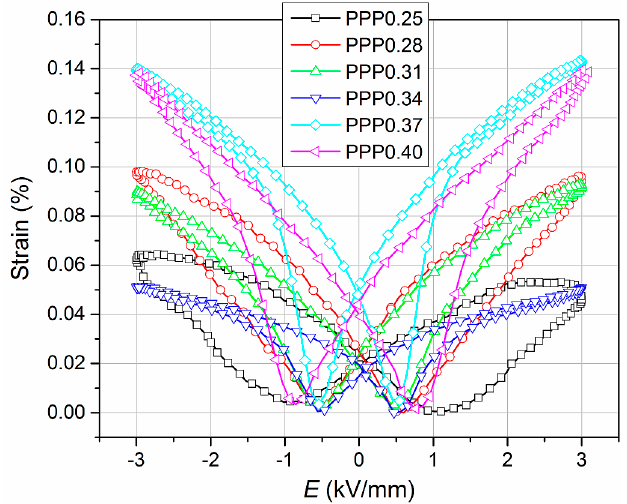
Figure 11. Strain vs. electric field of the PMN–PT–PS ceramics (1 Hz).